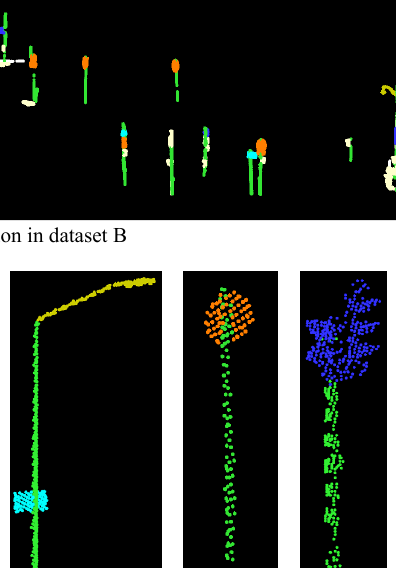
Figure 4. Correctly interpreted road furniture in Dataset